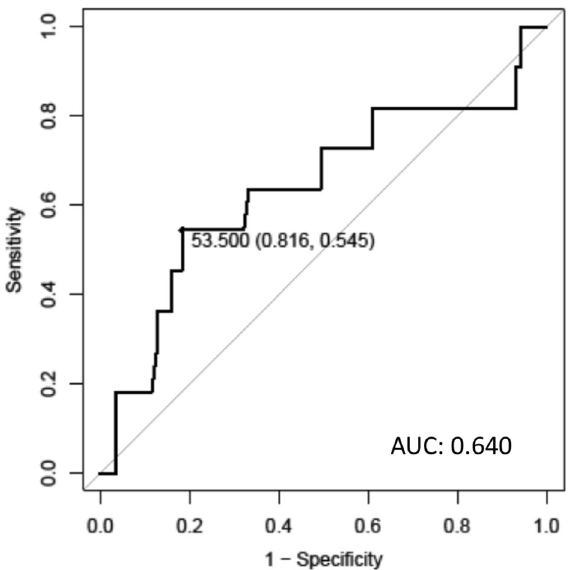
Figure 6. The receiver operating characteristic (ROC) curve of the relationship between the specificity and the sensitivity of the number of CD103 + TILs for lymph node metastasis.